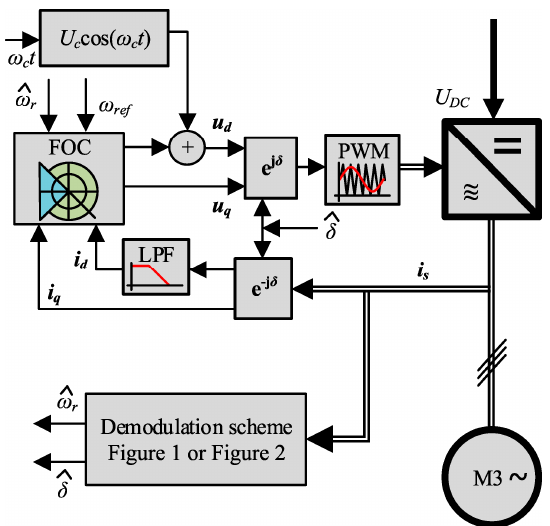
Figure 8. Control and demodulation scheme used for experimental procedure.